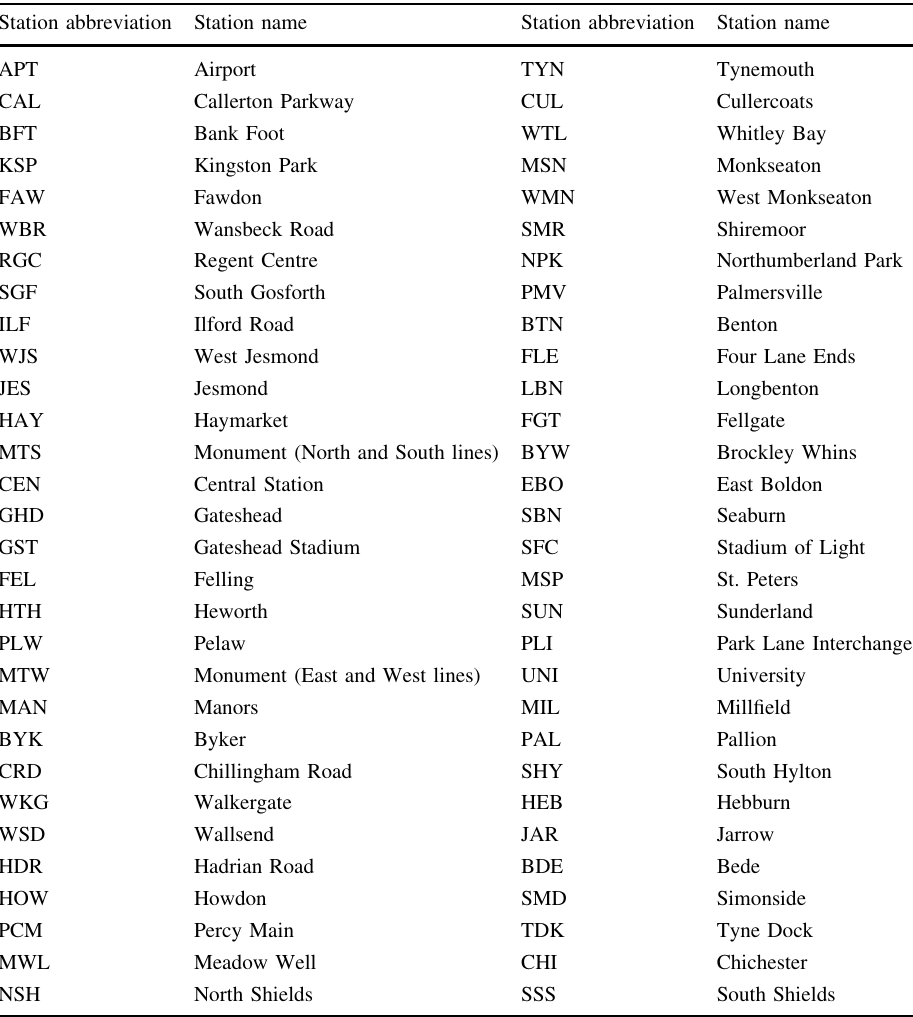
Table 1 Tyne and Wear